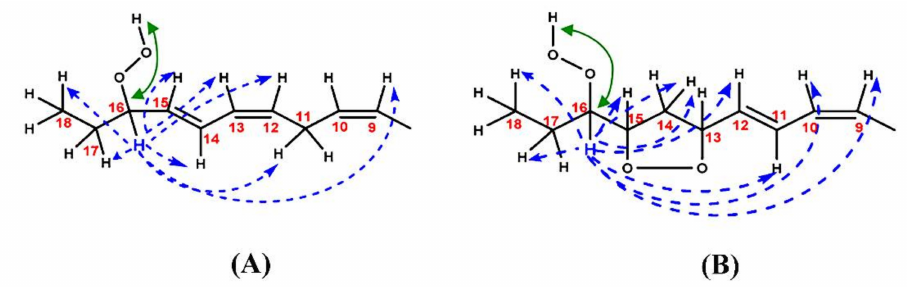
Figure 47. Schematic presentation of the combination of 1 H- 13 C HMBC (